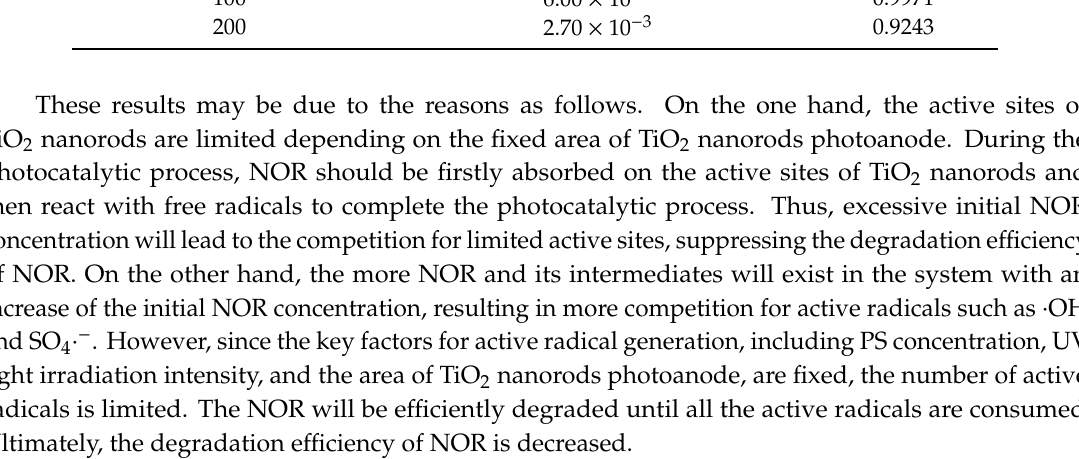
Figure 9. Effect of different reactive radical species on the degradation efficiency of NOR with 10 mg/L initial concentration in PFC/PS system. Experimental conditions: [EtOH] = [IPA] = 0.3 M, [EDTA- 2Na]=4mM, [PS]=3 mM, pH=3, and electrolyte: 0.1 M Na 2 SO 4 . 0